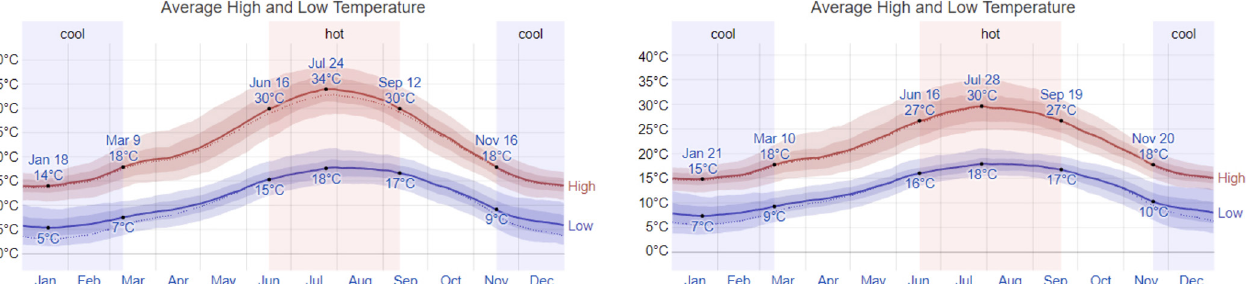
Fig. 3. Annual average high and low temperatures in Serpa and Odemira through the year. Image adapted from pt.weatherspark.com.